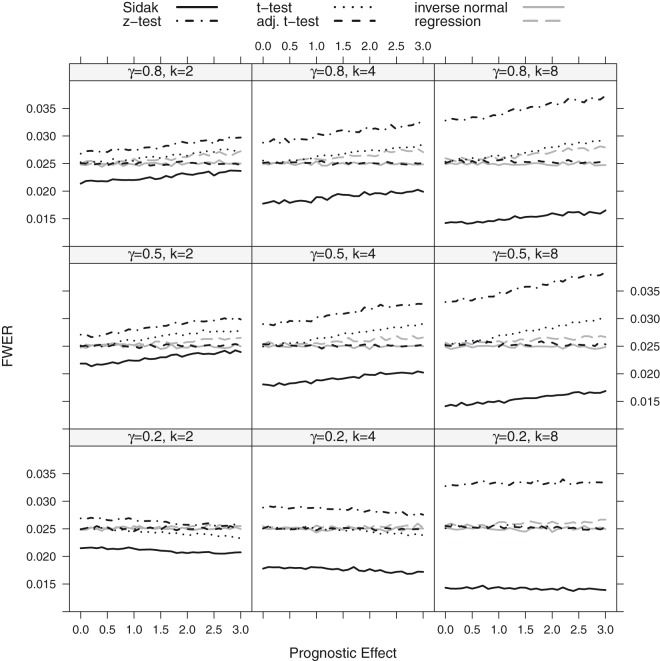
FWER as a function of the prognostic effect assuming a step function dependence for a sample size of n = 80. The number of thresholds was set to K = 2, 4, 8 with true cut-off γ=0.2,0.5,0.8. The black lines show the results for the Šidák (solid), the z-test (dot-dashed), the t-test (dotted) and the adjusted t-test (dashed) while the grey lines represent the regression procedure (dashed) and the inverse normal test (solid).